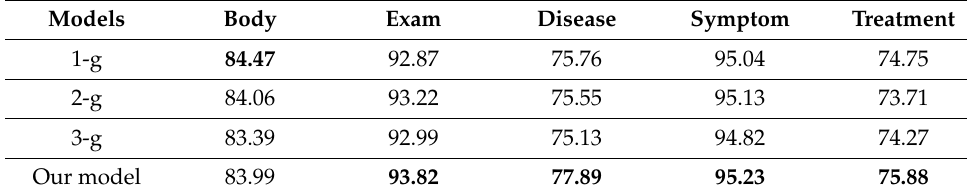
Table 6. Detailed F-score comparison for all entity